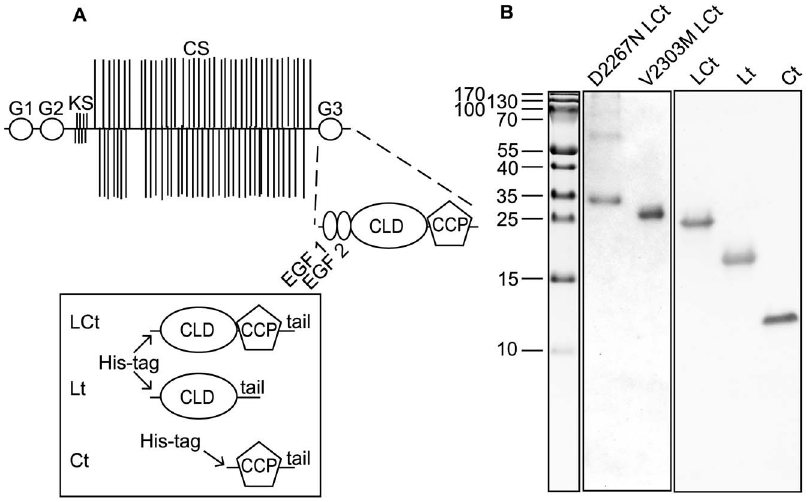
Figure 1. Structure of aggrecan and localization of G3 domain fragments which were used in the study. A, schematic outline of human aggrecan, including three globular domains (G1–G3), which is involved in numerous interactions with other ECM components. The carboxyl-terminal globular G3 domain consists of one or two EGF-like domains, a C-type lectin domain (CLD) and a complement control protein (CCP) domain followed by a short tail. In the current study we used three wild-type recombinant fragments of G3 domain: LCt, Lt and Ct and two mutants of LCt containing D2267N or V2303M substitutions. B , the wild-type and mutated fragments of G3 domain were expressed in eukaryotic cells and separated by SDS/ PAGE followed by Coomassie Blue